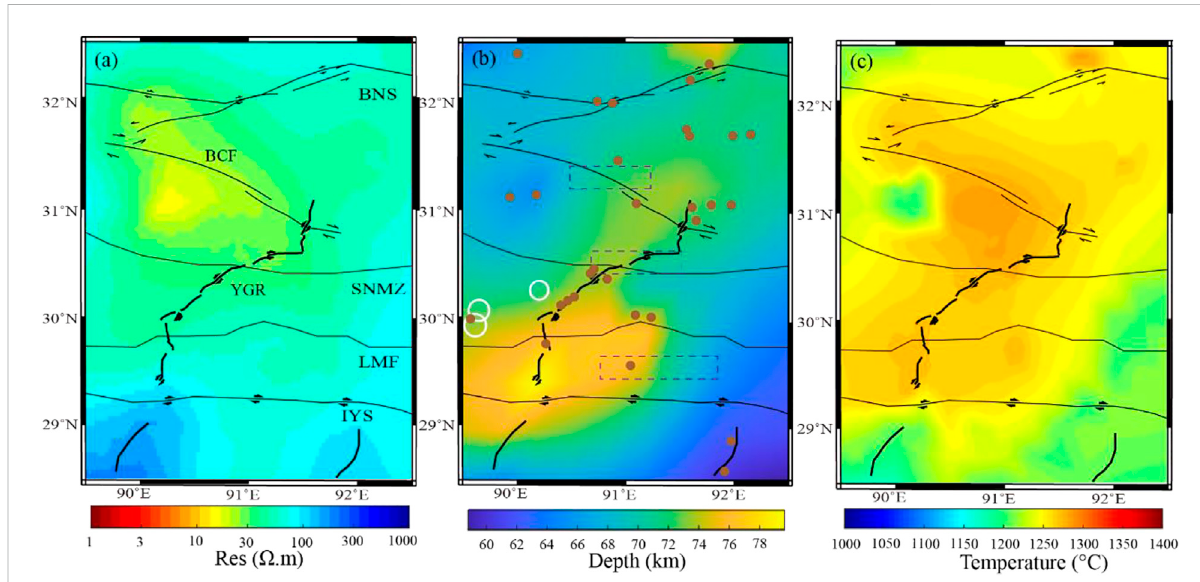
FIGURE 11 (A) A curved section of the 3-D electrical resistivity model along the Moho (B) Moho depth from a compilation of receiver function (Li et al., 2014); (C) Estimated Moho temperature [ C w ( H 2 O ) =150 ppm; C w ( CO 2 ) =.82 C w H 2 O , density-P], Purple dashed rectangles mark the locations of Moho offset from Zhang and Klemperer (2005), Tian et al. (2015) and Shi Z. et al. (2020). The brown fi lled circles mark high 3 He / 4 He ratio anomaly sample points (Klemperer et al., 2022). The white circles indicate intermediate-depth earthquakes ( ≥ 70 km ) from the high-quality (HQ) determinations (Chu et al., 2009)